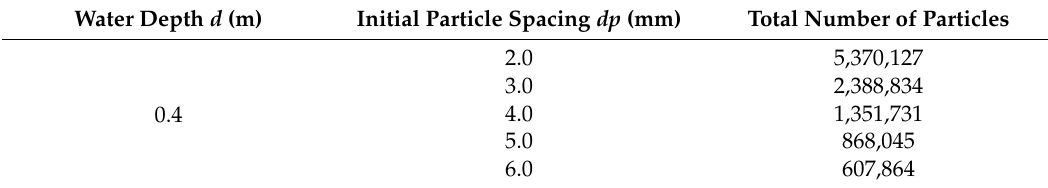
Table 5. Particle spacing and total particles for grid